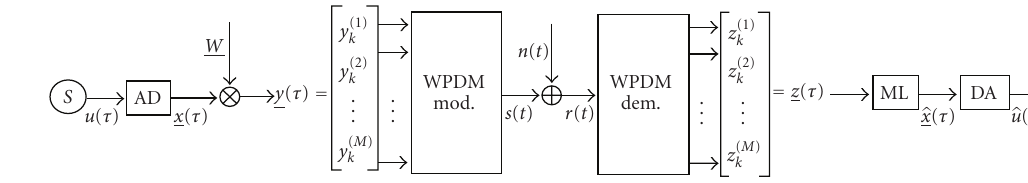
Figure 4: System model for UPA-WPDM.